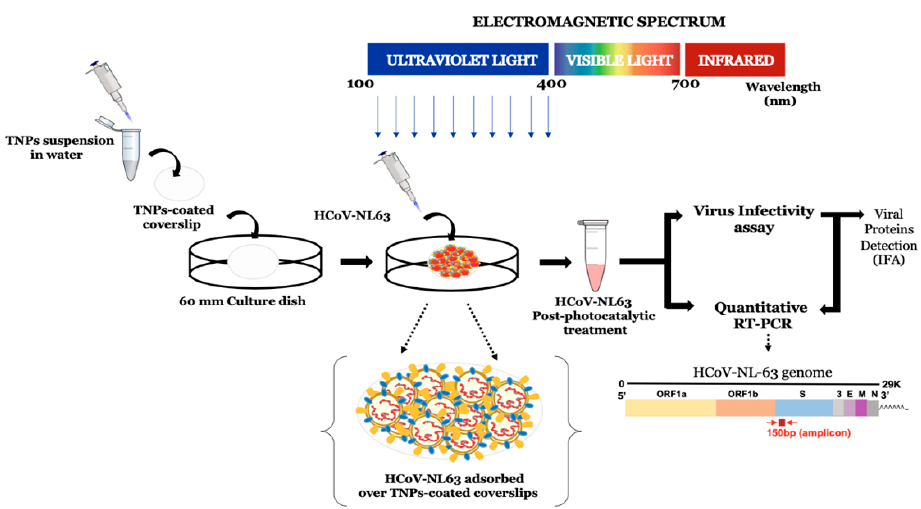
Figure 1. Schematic representation of the experimental set up utilized for the evaluation of photocatalytic inactivation of HCoV-NL63. TiO 2 nanoparticles (TNPs) were prepared as a suspension in water and deposited on glass coverslips by drying at 60 °C for 4–5 h. An aliquot (100 μ L) with calculated virions of HCoV-NL63 was placed on the TNP-coated coverslips and exposed to UV for indicated times. The TNP/UV-treated virus was then collected to determine the viral RNA stability and infectivity via quantitative RT-PCR, infectivity, and the detection of viral protein through immunofluorescence assay in HEK293L cells.